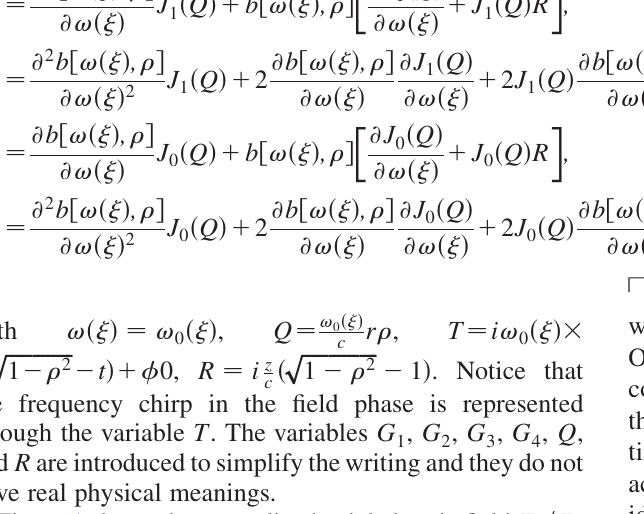
(b), t ¼ 10 T (c), and t ¼ 0 0 ¼ 20 T ¼ 0 , and the chirp , the initial phase (cid:6) 0 0 0